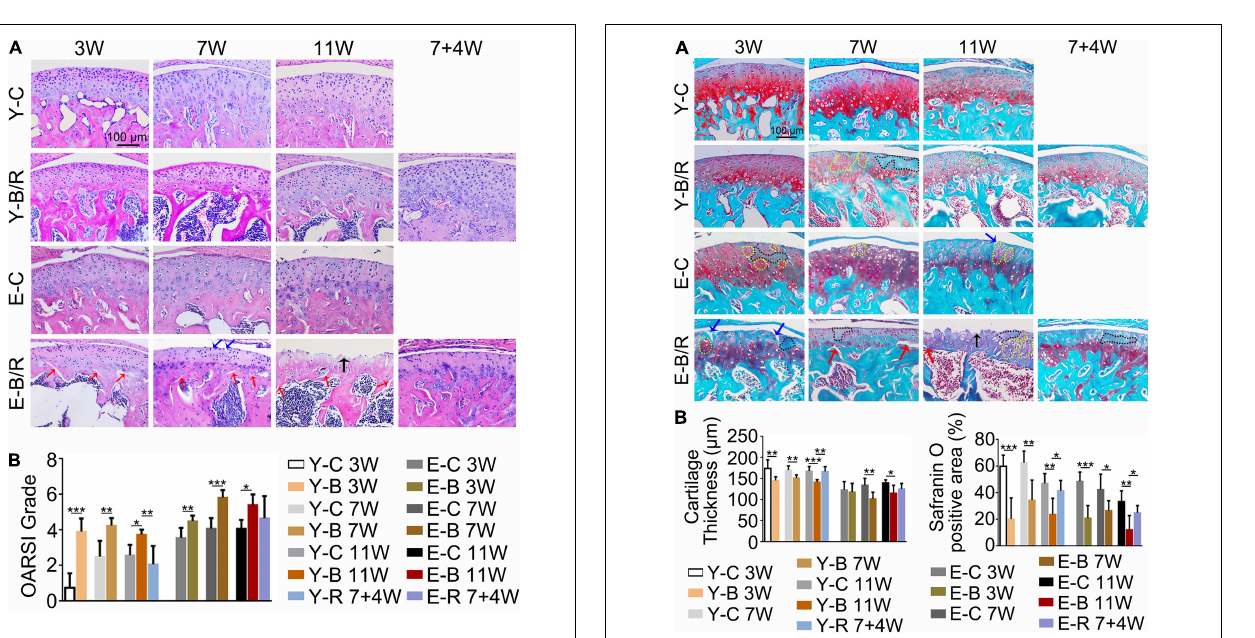
FIGURE 7 | (A) Representative Safranin O (SO) staining. The black arrow indicates the serrated injury at the surface of the cartilage. The blue arrows indicate the fissures at the surface of the cartilage. The red arrows indicate the fissures between cartilage and subchondral bone. Cells in the black-dotted areas are lacking. Cells in the yellow dotted areas are clustered. Bars = 100 µ m. (B) Comparison of the cartilage thickness and the size of the SO-positive area between the groups. Data are presented as mean ± SD. Unpaired t -test was used for comparisons between the age-matched control and BAC groups. One-way ANOVA was used for comparisons among the age-matched control, BAC, and BAC removal groups. n = 6. * P < 0.05; ** P < 0.01 and *** P < 0.001 for the differences between all BAC and removal groups and the age-matched control groups. For grouping and time points, please refer to Figure 1A